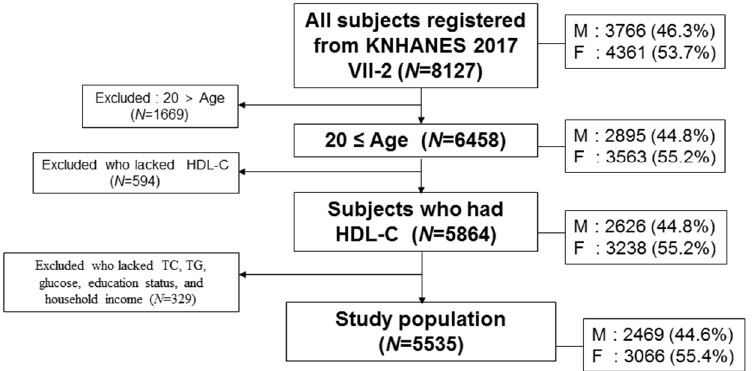
Figure 1. Inclusion criteria and subject number in analysis. HDL-C, high-density lipoprotein cholesterol. TC, total cholesterol. TG, triglycerides. M: men. F: Female.